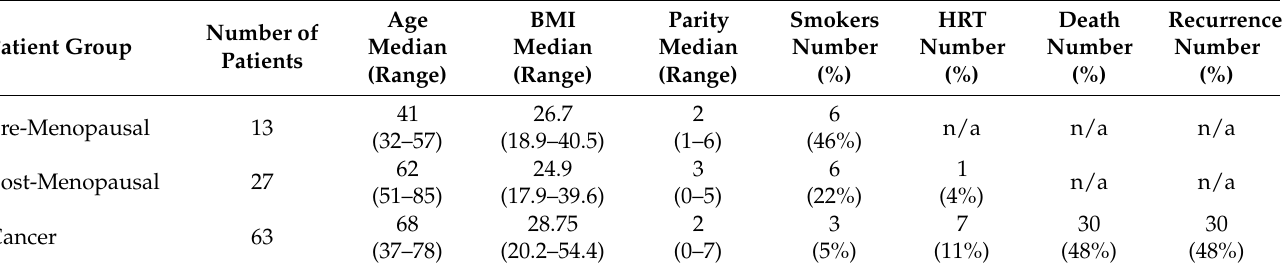
Table 1. Patient cohort demographic